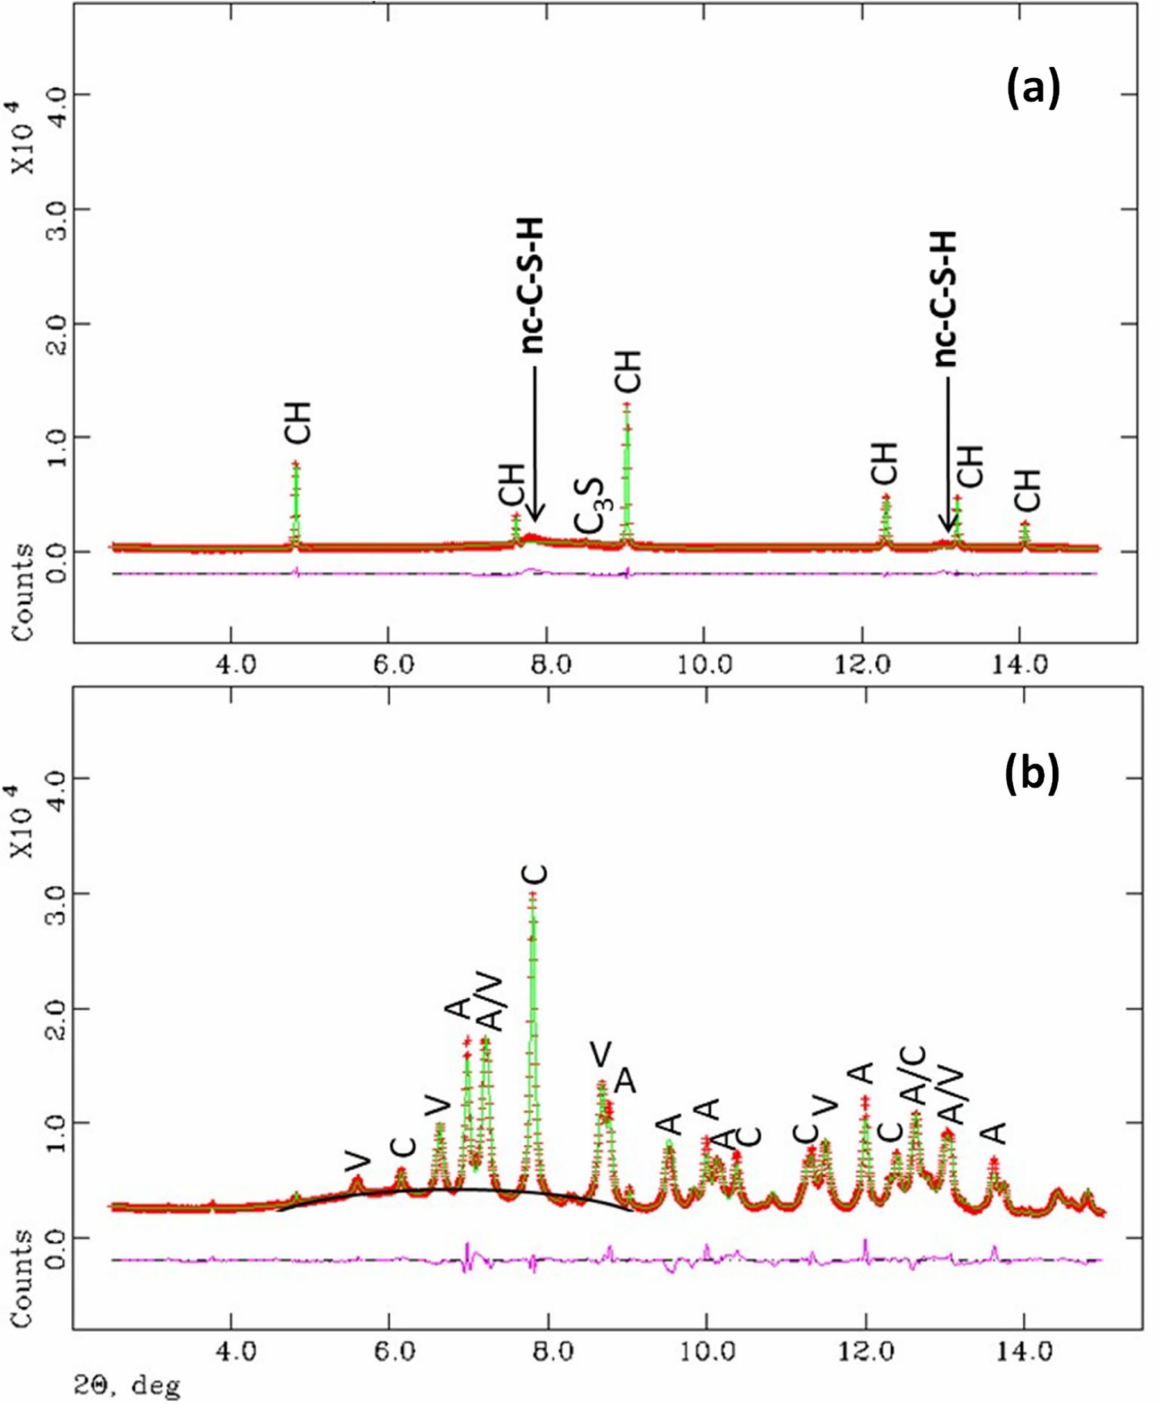
Figure 4. Selected low angle ranges (intensity vs. 2 θ ) of the synchrotron Rietveld plots ( λ = 0.41 Å) for ( a ) hydrated t-C 3 S for 5 months and ( b ) the C 3 S paste after carbonation for 80 days at 3% of CO 2 (T = 20 ◦ C and RH = 65%). The main peaks are labelled. Top pattern: Portlandite (CH), alite (C 3 S) and nanocrystalline C-S-H gel ( nc-C-S-H ). Bottom pattern: calcite (C), aragonite (A) and vaterite (V). The increase in the background centred at ~7 ◦ /2 θ for C 3 S_carb is